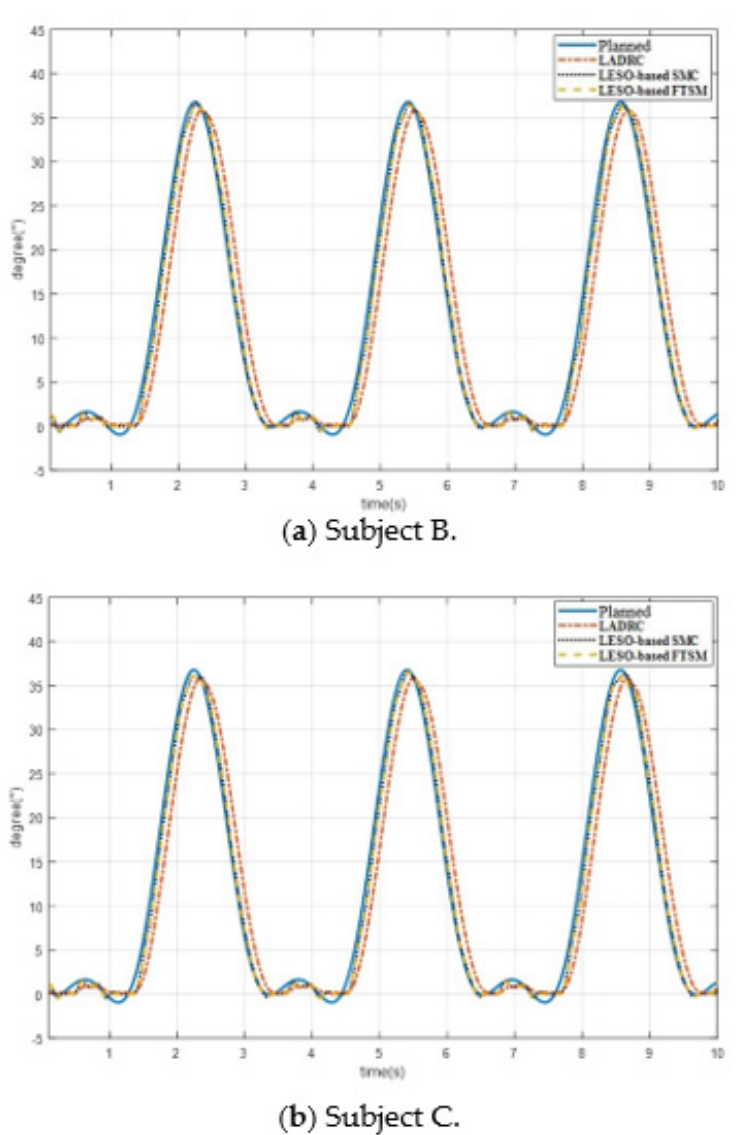
Figure 20. Trajectories of hip joint for different subjects. The comparisons of hip joint trajectories for the subjects are presented in Table 2. Table 2. RMSE of different subjects’ hip joint trajectories for LADRC, LESO-based SMC, and LE- For subject B, the RMSEs of trajectories by the proposed three controllers did not vary SO-based FTSMC. much more, and had smaller values as compared to subjects A and C. But for the subjects A and C with comparatively larger weights, the RMSEs of the rehabilitation trajectories could be decreased noticeably by LESO-based nonlinear controllers. The results showed that a heavy subject, implying larger inertia of the lower extremities, may result in a larger disturbance during walking. The linear LADRC was not enough to compensate the estimated disturbance errors. In addition, the wearer’s height did not noticeably affect the trajectory tracking